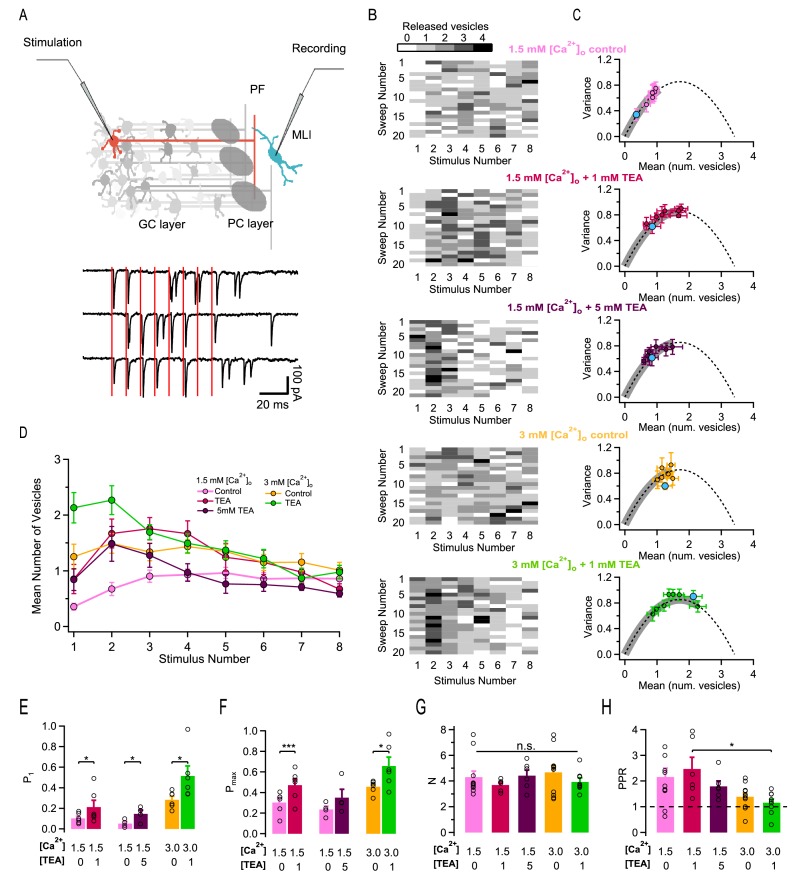
Effects of different release conditions on synaptic parameters and short-term plasticity.(A) Upper panel: Schematics of recording configuration. A stimulation pipette is positioned close to the soma of a potential presynaptic granule cell while whole-cell recording from a MLI. Careful presynaptic pipette positioning and stimulation strength adjustment results in selective stimulation of a single PF-MLI connection. Lower panel: Individual traces in response to AP trains (8 stimuli, 100 Hz; stimulation timing in red). (B) Deconvolution-based counts of released SVs per stimulus. Matrices of SV numbers as a function of AP number for 5 individual experiments are illustrated in different external solutions (from top to bottom: 1.5 mM [Ca2+]o in control, in 1 mM TEA, and in 5 mM TEA; 3 mM [Ca2+]o in control and in 1 mM TEA). Each experiment involved a control period and another set of data in one TEA concentration. Accordingly, the two SV count matrices in 1.5 mM [Ca2+]o without TEA and with 1 mM TEA stem from the same experiment. Likewise, the two SV count matrices in 3 mM [Ca2+]o without TEA and with 1 mM TEA stem from the same experiment. (C) Group results of the variance-mean relationship of the number of released vesicles calculated per stimulus (mean ± SEM; results for the first stimulus in blue). The dashed lines represent the parabolic fit after pooling the results in all conditions; it indicates an N = 3.6. Gray thick traces show the excursion over this parabola from the origin until the value that displays the highest P. (D) Time course of SV numbers during a train showing changes in short term synaptic plasticity with [Ca2+]o and TEA (same data set as in C). (E–H) Group analysis (bars: mean ± SEM, n = 4–12; circles: individual experiments) show an increase of the release probability for the 1st stimulus as a function of TEA (E), an increase of the maximal release probability as a function of TEA (F), no change in N (G), and a decrease of the PPR as a function of [Ca2+]o and TEA (H). Statistical comparisons use paired t-tests in E-F, and unpaired t-tests for all combinations in G-H. No symbol or n.s. = p > 0.05; *=p < 0.05; **=p < 0.01; ***=p < 0.001.